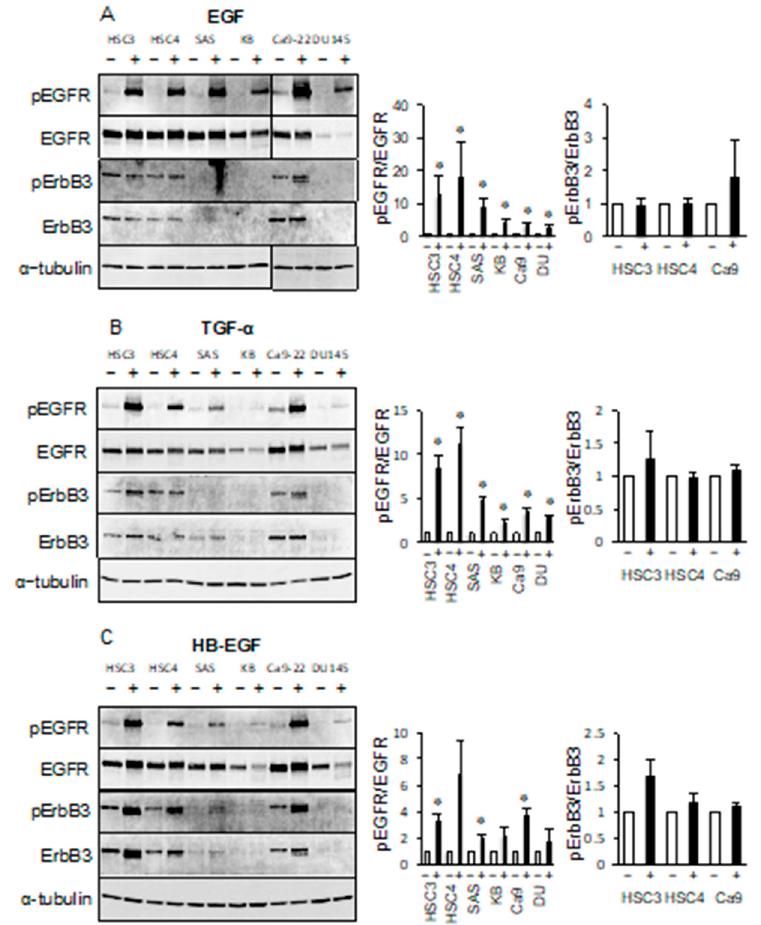
Figure 4. EGFR ligands are not involved in the phosphorylation of ErbB3. Cells were treated with ( A ) epidermal growth factor (EGF), ( B ) transforming growth factor- α (TGF- α ), ( C ) heparin-binding EGF-like growth factor (HB-EGF), and the phosphorylation levels of EGFR and ErbB3 were determined by western blotting analysis. α -tubulin was used as the loading control. * Significantly different from control, p < 0.05. Experiments were performed three times independently.